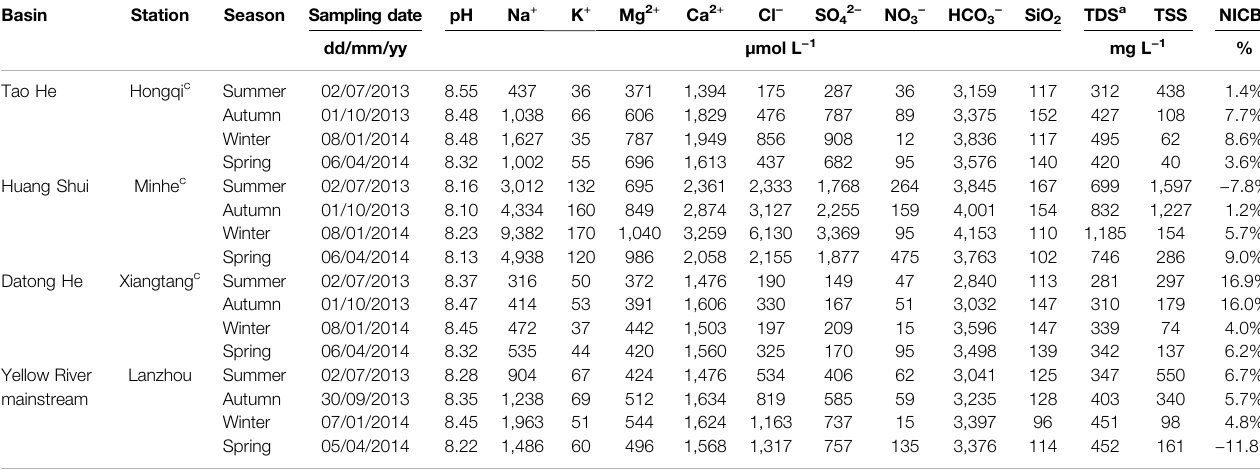
TABLE 2 | Seasonal dissolved chemical composition at the outlets of the Tao He, Huang Shui, and Datong He and the Lanzhou station on the Yellow River mainstream. Basin